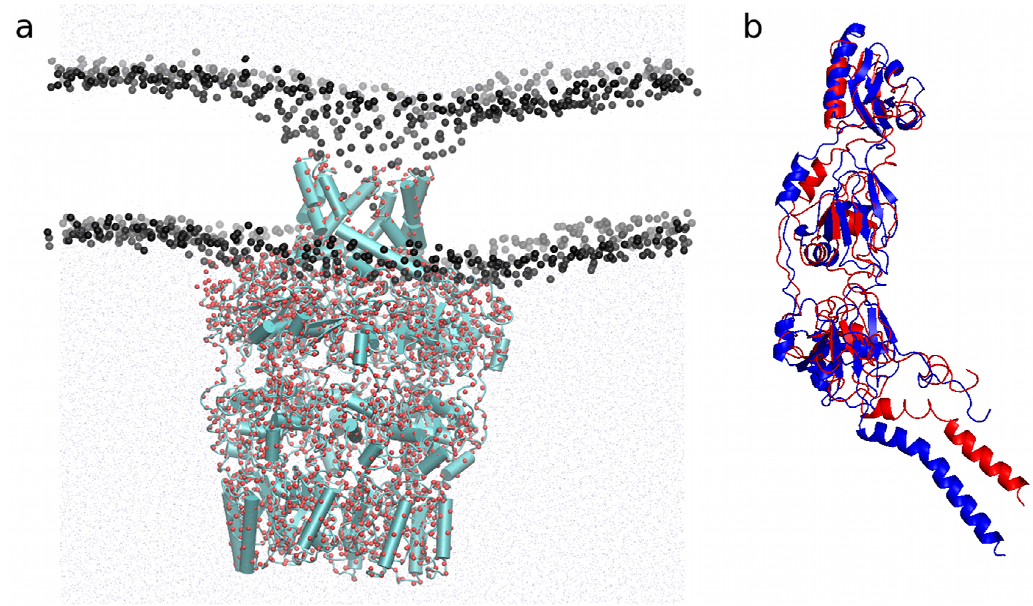
Figure 8. ( a ) Atomistic representation of the octamer of WZA inserted in the membrane. Phosphate group of the lipids are represented in black, secondary structures are represented in blue and the coarse-grained beads representing the final structure of the CG insertion dynamics are overplayed in red. The water is in light blue and the lipids are not shown excepted for the phosphate beads; ( b ) Comparison of one monomer before (blue) and after insertion